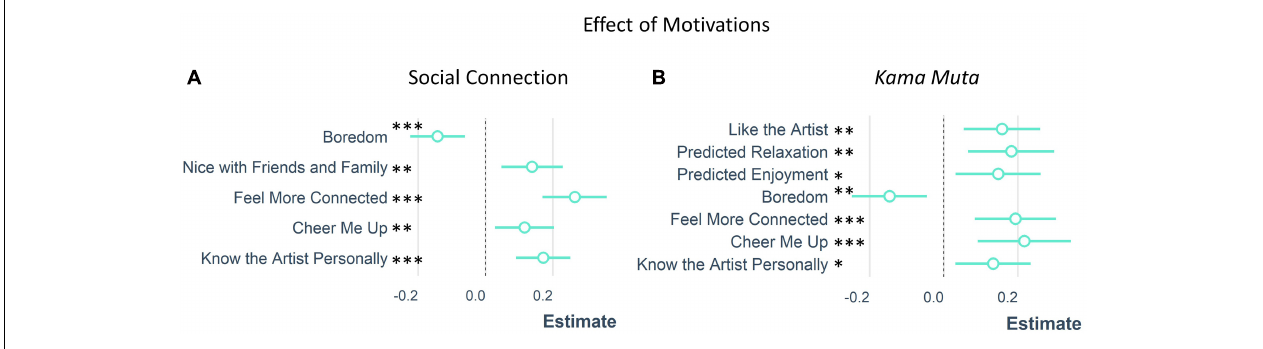
FIGURE 7 | The effect of concert attendance motivations on (A) social connection and (B) kama muta. ∗ p < 0.05, ∗∗ p < 0.01, and ∗∗∗ p < 0.001.